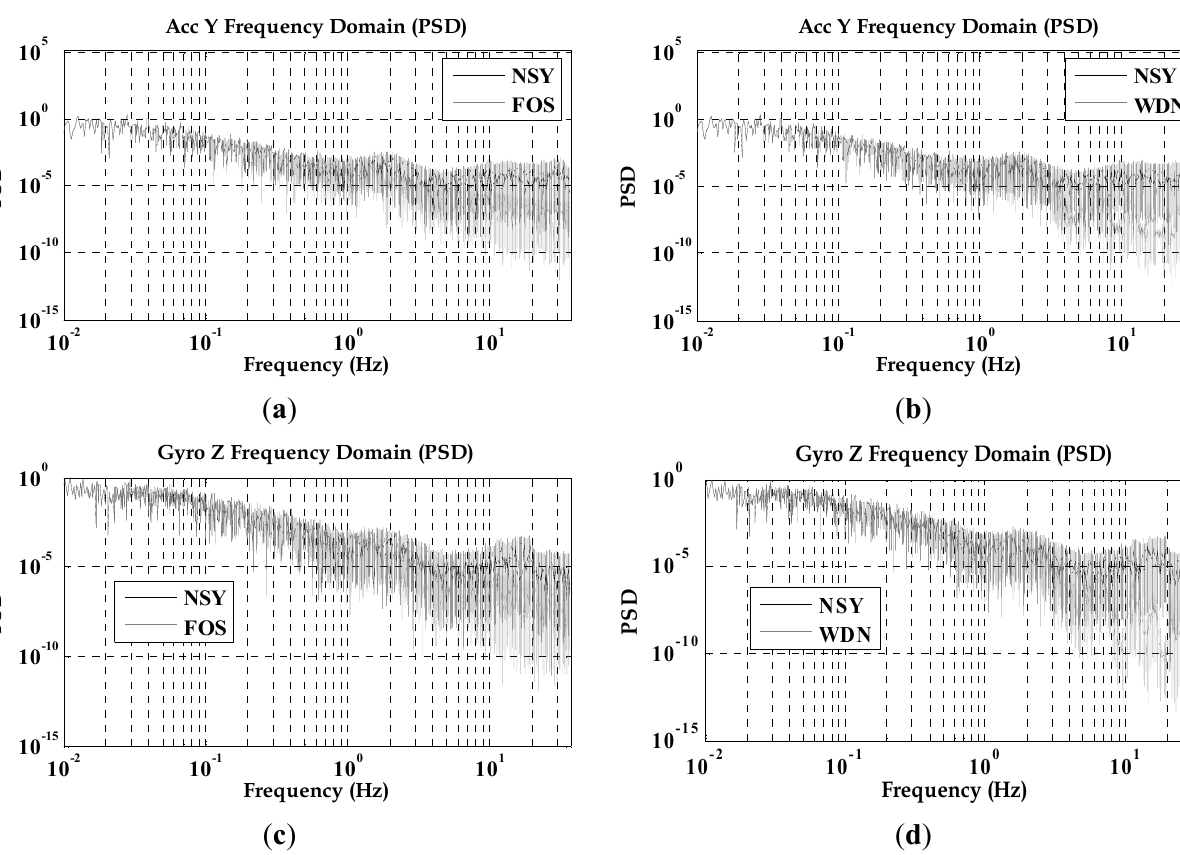
Figure 7. PSD plots for TG6000 inertial sensors before and after applying both FOS and